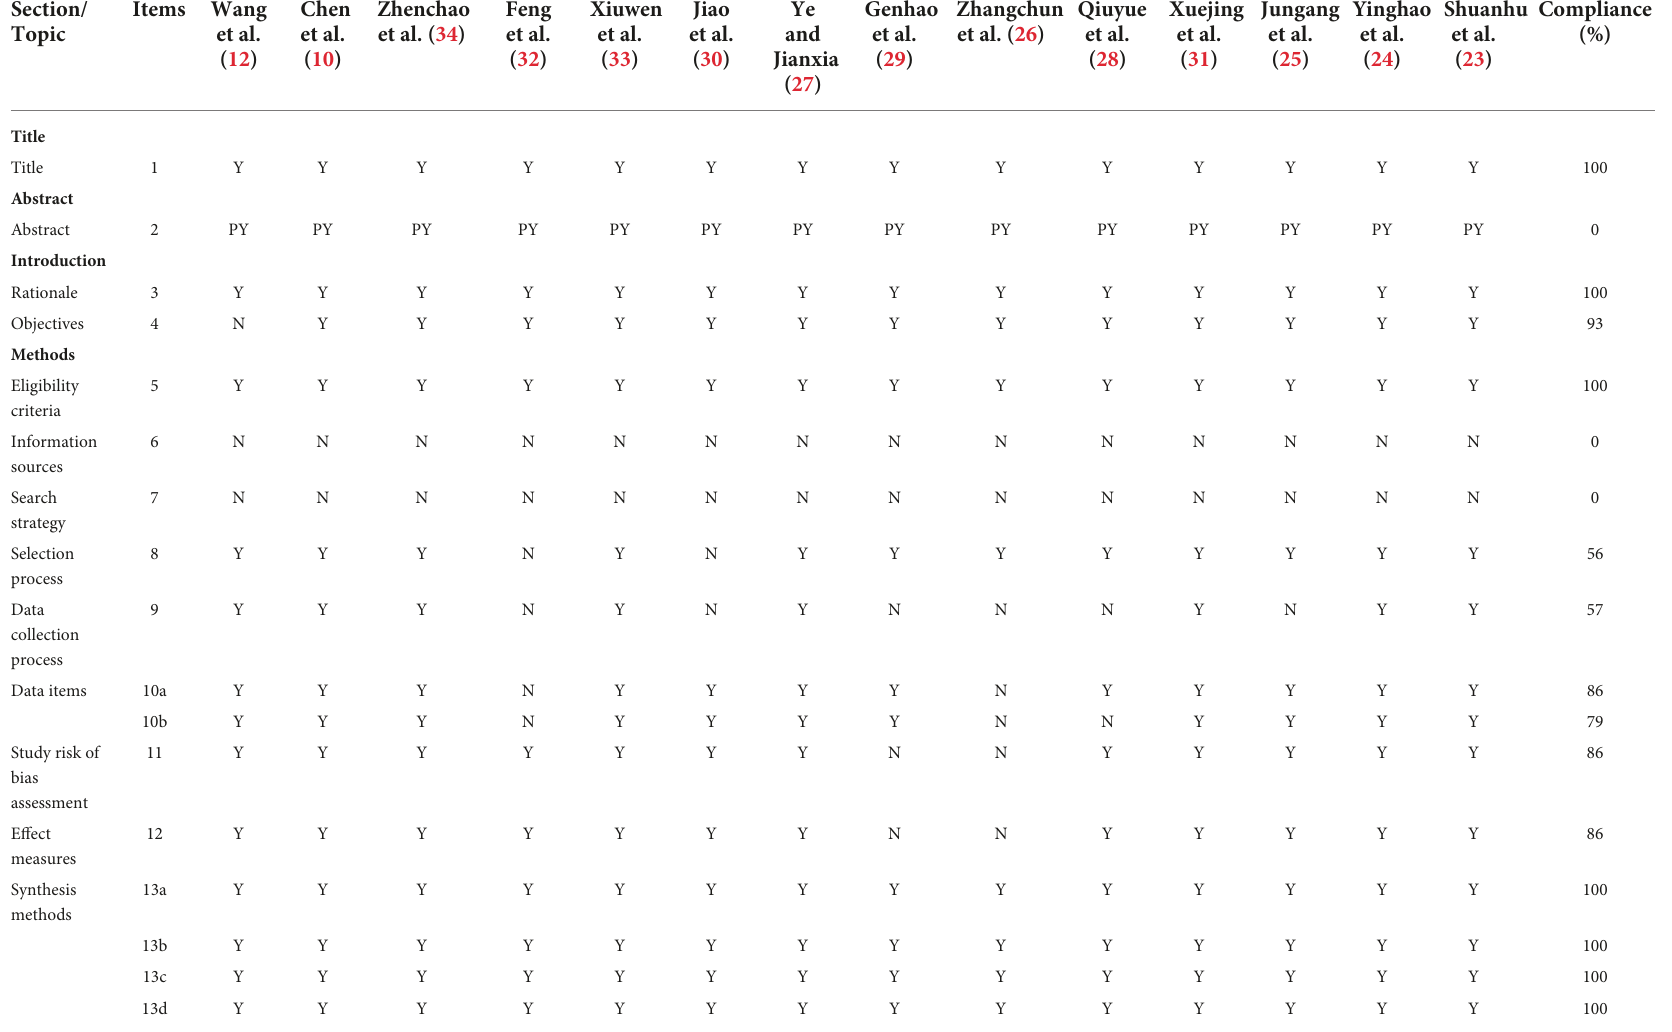
TABLE 5 Results of the PRISMA